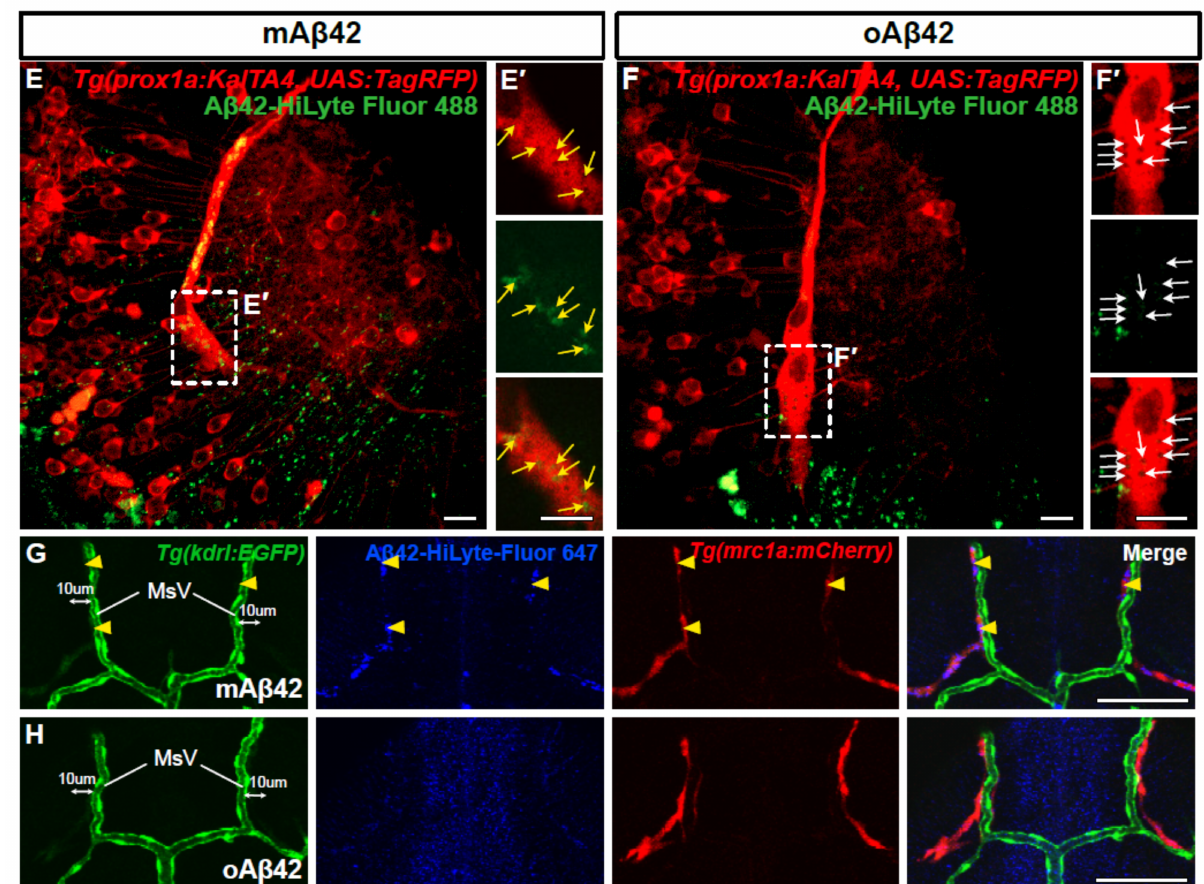
Figure 3. Brain lymphatic endothelial cells take up monomeric A β 42, but not oligomeric A β 42. ( A ) A schematic diagram of the larval brain with the dorsal view. Red lines in the dotted box depict the loop structure of the brain lymphatic endothelial cells (BLECs) in the optic tectum. ( B ) Quantification of the co-localization of A β 42 with BLECs. Data are presented as mean ± SEM. n = 9 for mA β 42 and n = 7 for oA β 42. Statistical significance was determined by two-tailed unpaired t -test. ( C ) Quantification of the numbers of mrc1a + BLECs in the optic tectum after mA β 42 or oA β 42 injection in the Tg(mrc1a:mCherry) . Data are presented as mean ± SEM. n = 9 per group. ( D ) Quantification of the number of A β 42 positive BLECs nearby (within 10 µ m) mesencephalic vein (MsV) region showing mrc1a+ positivity. Statistical significance was determined by ordinary one-way ANOVA with Tukey’s test. n = 10 for mA β 42 and n = 8 for oA β 42. ( E , F ) Confocal projections of prox1a:RFP+ BLECs and A β 42-HiLyte Fluor 488. ( E (cid:48) , F (cid:48) ) High magnification of dotted boxes in ( E , F ) showing endocytic vesicles of BLECs. mA β 42-injected BLECs showed robust uptake of mA β 42 into endocytic vesicles (( E (cid:48) ), yellow arrows) whereas oA β 42-injected did weak uptake (( F (cid:48) ), white arrows). Scale bars in ( E – F (cid:48) ) = 10 µ m. ( G , H ) Confocal fluorescence images of the brain optic tectum region with double transgenic Tg ( kdrl:EGFP ); Tg ( mrc1a:mCherry ) larvae after A β 42 injection (HiLyte Fluor 647-A β 42) at 3 dpf. mA β 42 fluorescence detected in the neighboring (within 10 µ m) kdrl:EGFP + cerebrovasculature was mostly co-localized with mrc1a:mCherry+ BLECs (yellow arrowheads) ( G ), whereas oA β 42 ( H ) fluorescence neighboring kdrl:EGFP + cerebro-vasculatures was not. HB, hindbrain; OT, optic tectum; MsV, mesencephalic vein; Scale bars in ( G , H ) = 50 µ m. ns, not significant; **** p <